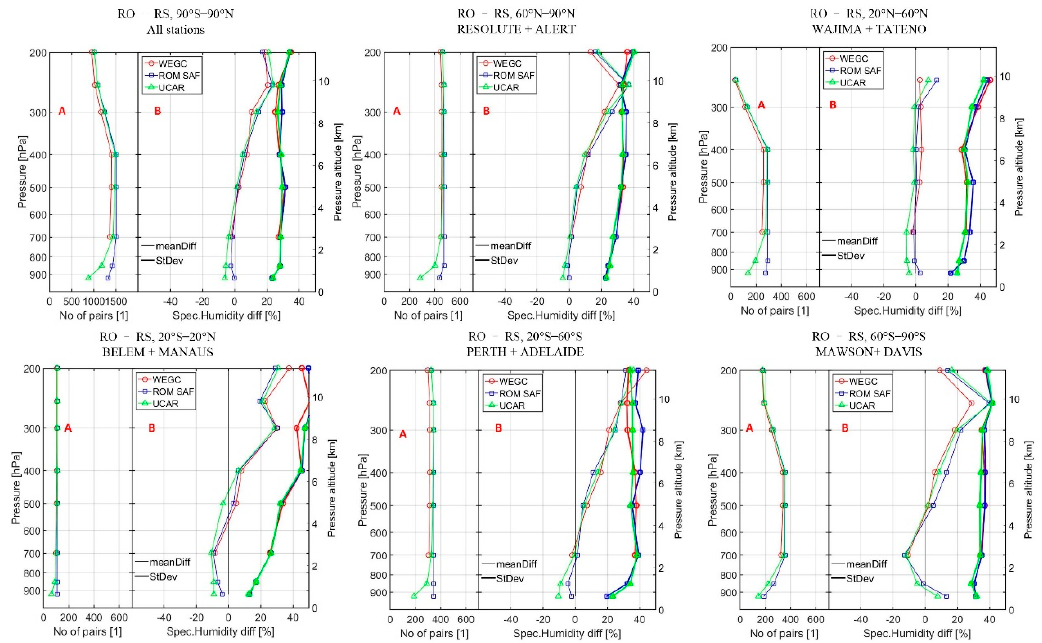
Figure 3. Specific humidity mean di ff erences (meanDi ff ) and corresponding standard deviations (StDev) between RO and RS of WEGC, ROM SAF and UCAR over the period of 2007 to 2010 selected IGRA stations over latitudinal bands of 90 ◦ S–90 ◦ N, 60 ◦ N–90 ◦ N, 20 ◦ N–60 ◦ N, 20 ◦ S–20 ◦ N, 20 ◦ S–60 ◦ S, and 60 ◦ S–90 ◦ S; the number of paired samples at all pressure levels is indicated in sub-panel A. Table 3. Specific humidity mean di ff erences (meanDi ff ) and corresponding standard deviations (StDev) between RO and RS of the three centers at selected pressure levels of 200, 400 and 700 hPa. Specific Humidity meanDi ff (Stdev) [%] Lat Band Station Pressure Level [hpa] WEGC ROM SAF UCAR 90 ◦ S–90 ◦ N All stations